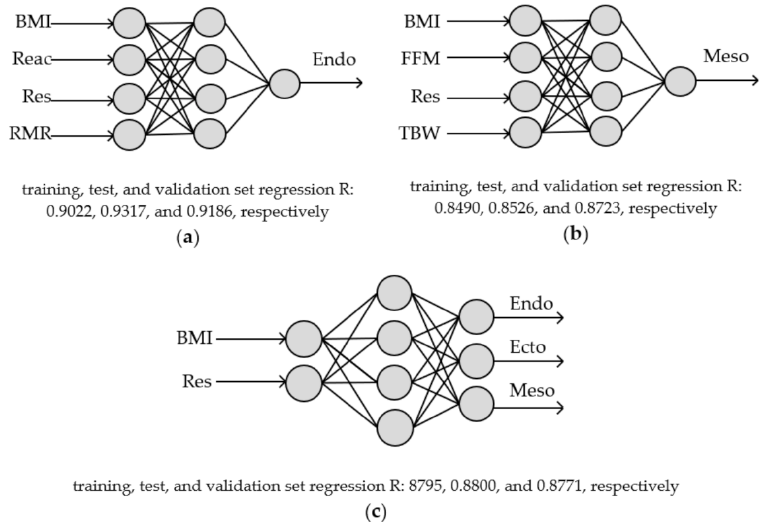
Figure 1. Three layer neural networks: ( a ) MLP 4-4-1 for Endo somatotype, ( b ) MLP 4-4-1 for Meso somatotype and ( c ) MLP 2-4-3 for Endo, Ecto and Meso somatotypes; transfer functions: hidden and output layers: tangent sigmoid and linear,